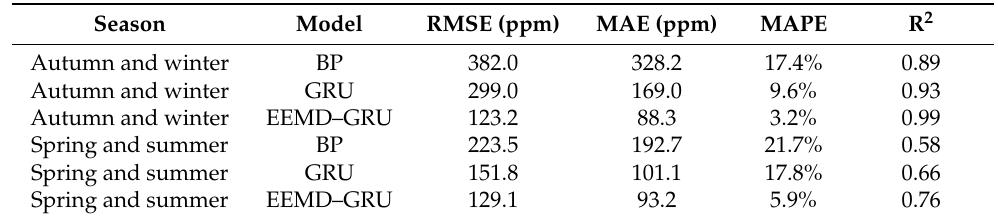
compared with the other two models, the RMSE, MAE, MAPE, and R 2 errors of the three